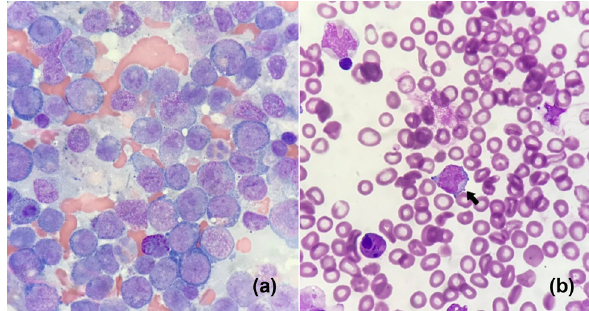
Figure 2: ( a ) Bone marrow aspiration revealed a hypercellular marrow with di ff use in fi ltration of myeloblasts with vesicular nuclei and scanty cytoplasm. ( b ) Pleural fl uid cytology ( cell block ) was notable for the presence of atypical cells with enlarged and hyper - chromatic nuclei and scant cytoplasm ( arrow )